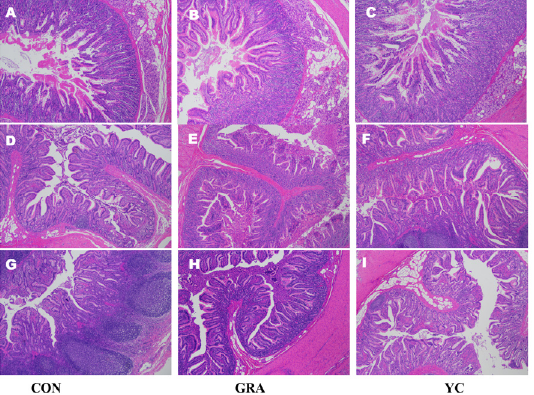
Figure 1. Effect of yeast culture supplementation on intestinal histology of finishing pigs. ( A – C )